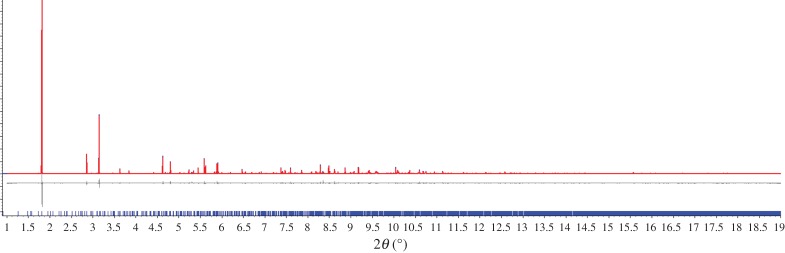
Observed (blue) and calculated (red) profiles and difference plot [(Iobs − Icalcd)] (grey) at 298 K of the Pawley refinement for 1-MeOH (1.0 ≤ 2θ ≤ 19.0°, dmin = 1.22 Å); Rwp = 0.162; Rwp′ = 0.200.